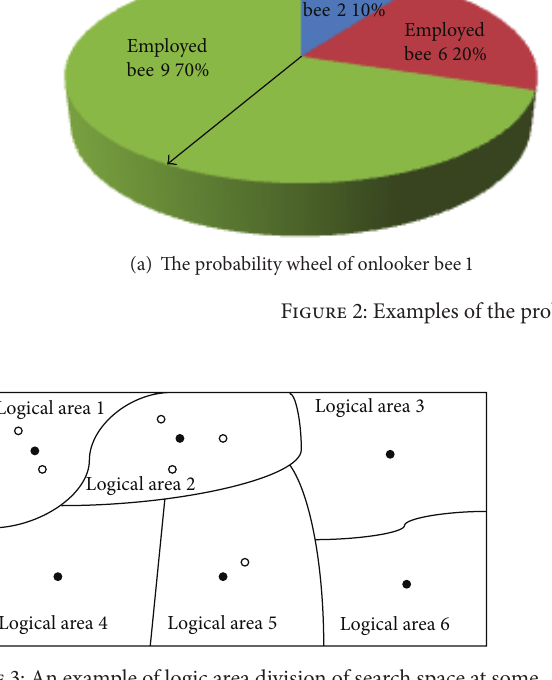
Figure 3: An example of logic area division of search space at some